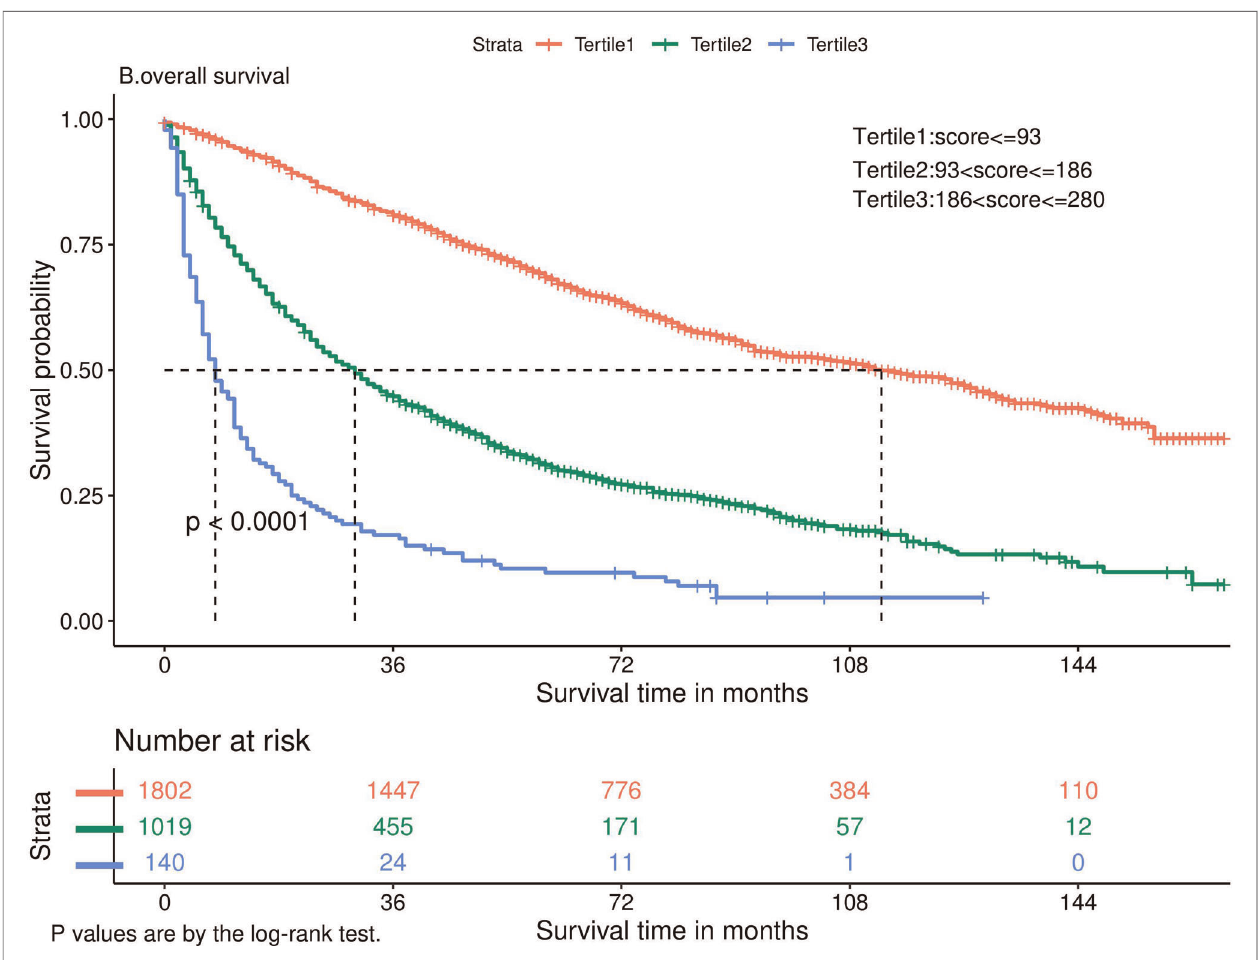
FIGURE 4 | Kaplan-Meier